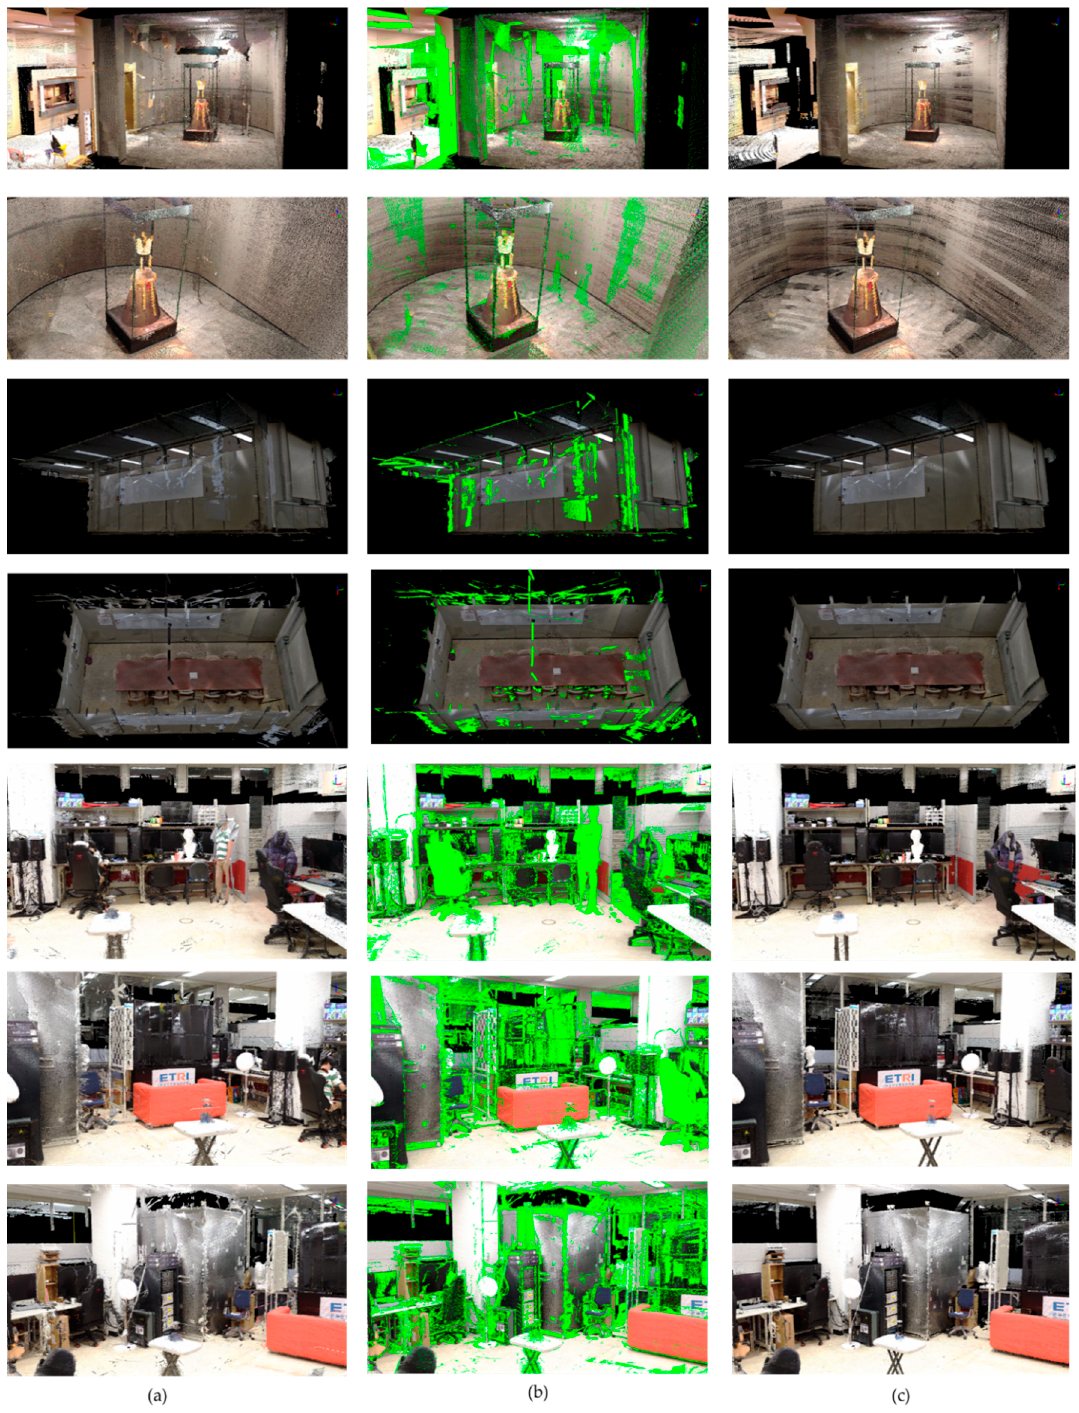
Figure 18. Results of the proposed method using different datasets. ( a ) is the original point cloud image, ( b ) the green part of the figure is the reflected noise region detected by our method, and ( c ) is the result obtained after denoising using our method.